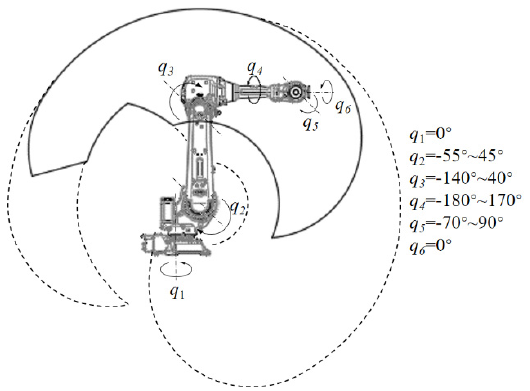
Figure 3. Partial variable range.